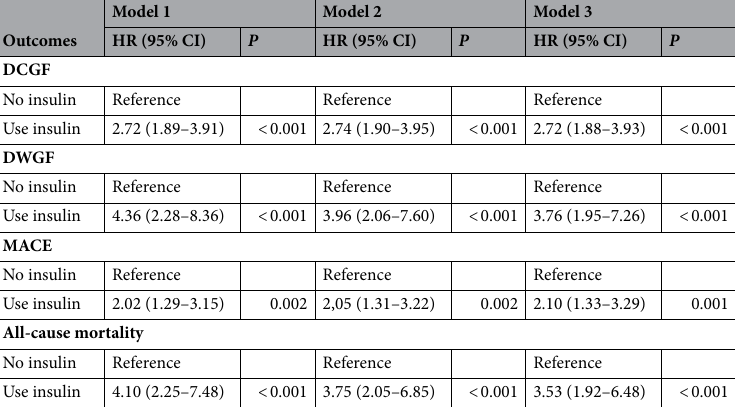
Table 3. Subgroup analyses in KT recipients according to the use of insulin. Model 1: Univariate analysis. Model 2: Model 1 + adjustment with age, sex, history of hypertension, dyslipidemia, and cardiovascular disease, dialysis modality, duration of dialysis. Model 3: Model 2 + adjustment with induction therapy, desensitization, rejection, use of steroid. HR hazard ratio, CI confidence interval, DCGF death-censored graft failure, DWGF death with graft function, MACE major adverse cardiovascular